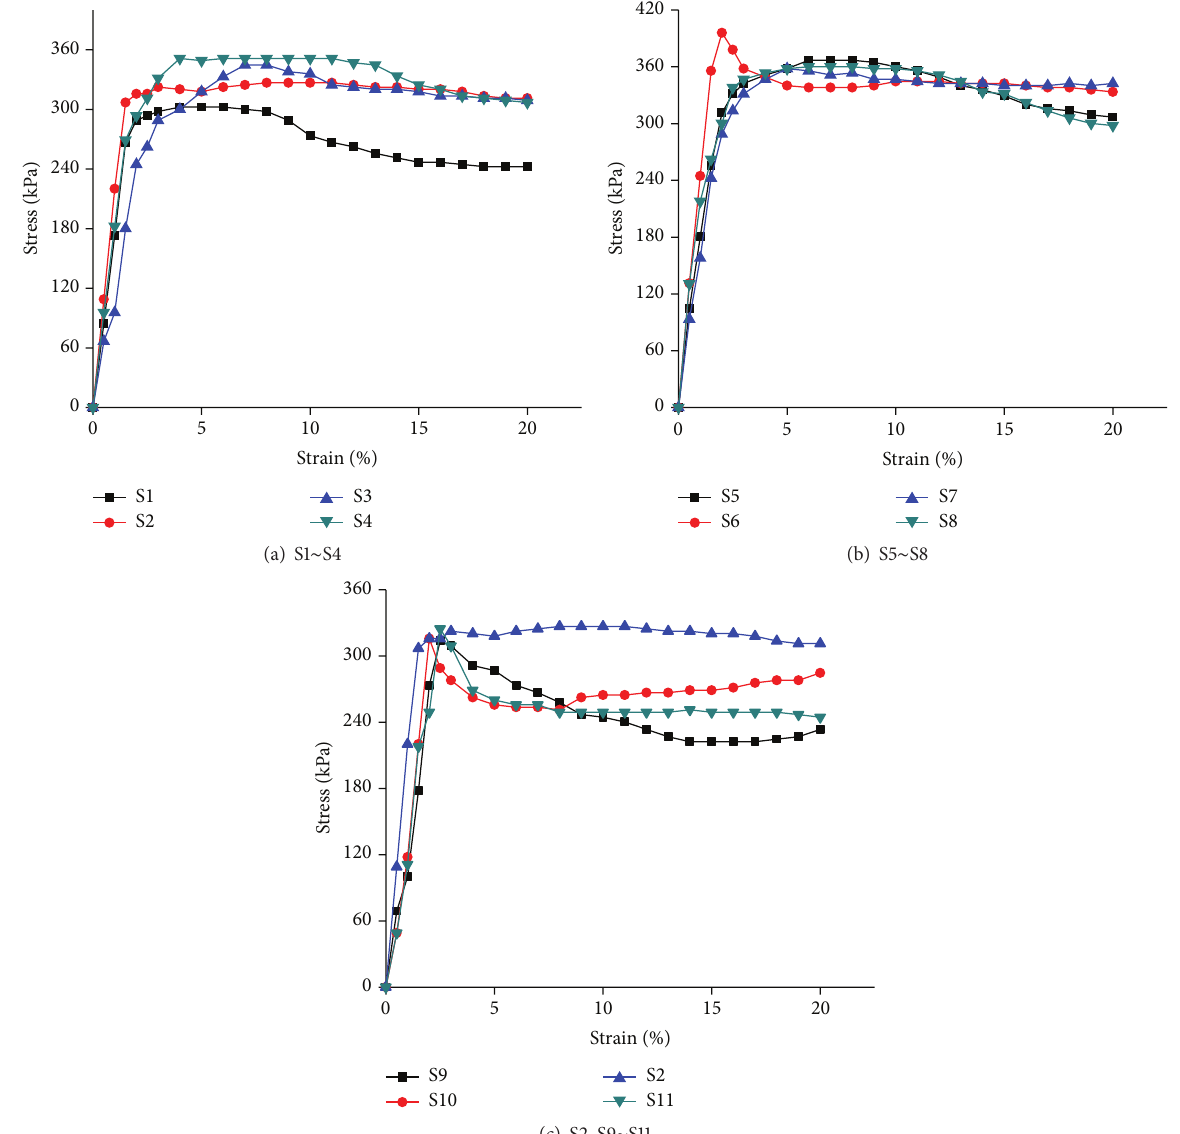
Figure 2: Stress-strain curves of unconfined compressive strength for the